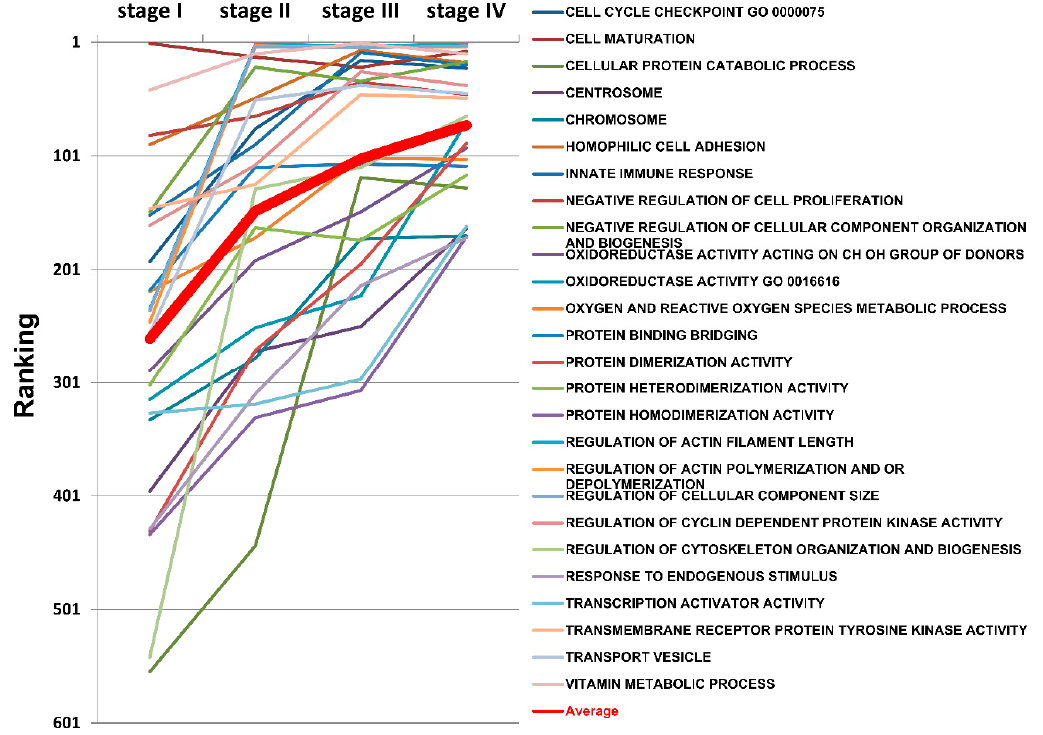
Figure 8. The rankings of the progressively deregulated GO terms from SC stage I to IV. The GO terms that were statistically significant and moved upward in rankings from SC stage I to IV were selected; a total of 26 GO terms met the criteria. The paths of the changes in ranking from stage I to IV of these progressively deregulated GO terms is displayed on the line chart.